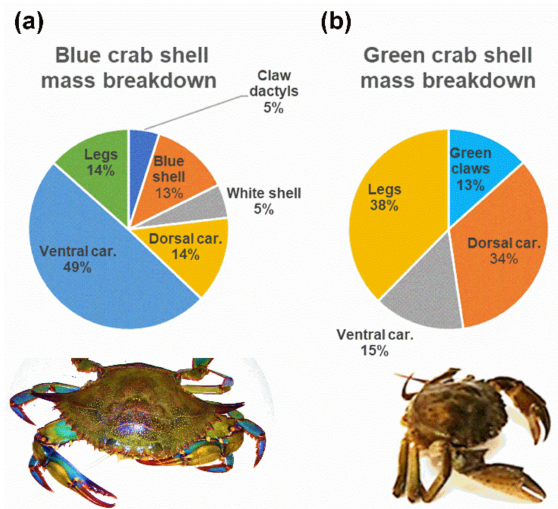
Figure 1. Weight fractions of particular anatomical shell parts of the two crustacean species: ( a ) the Atlantic blue crab ( Callinectes sapidus ) and ( b ) the Mediterranean green crab ( Carcinus aestuarii ). Car =